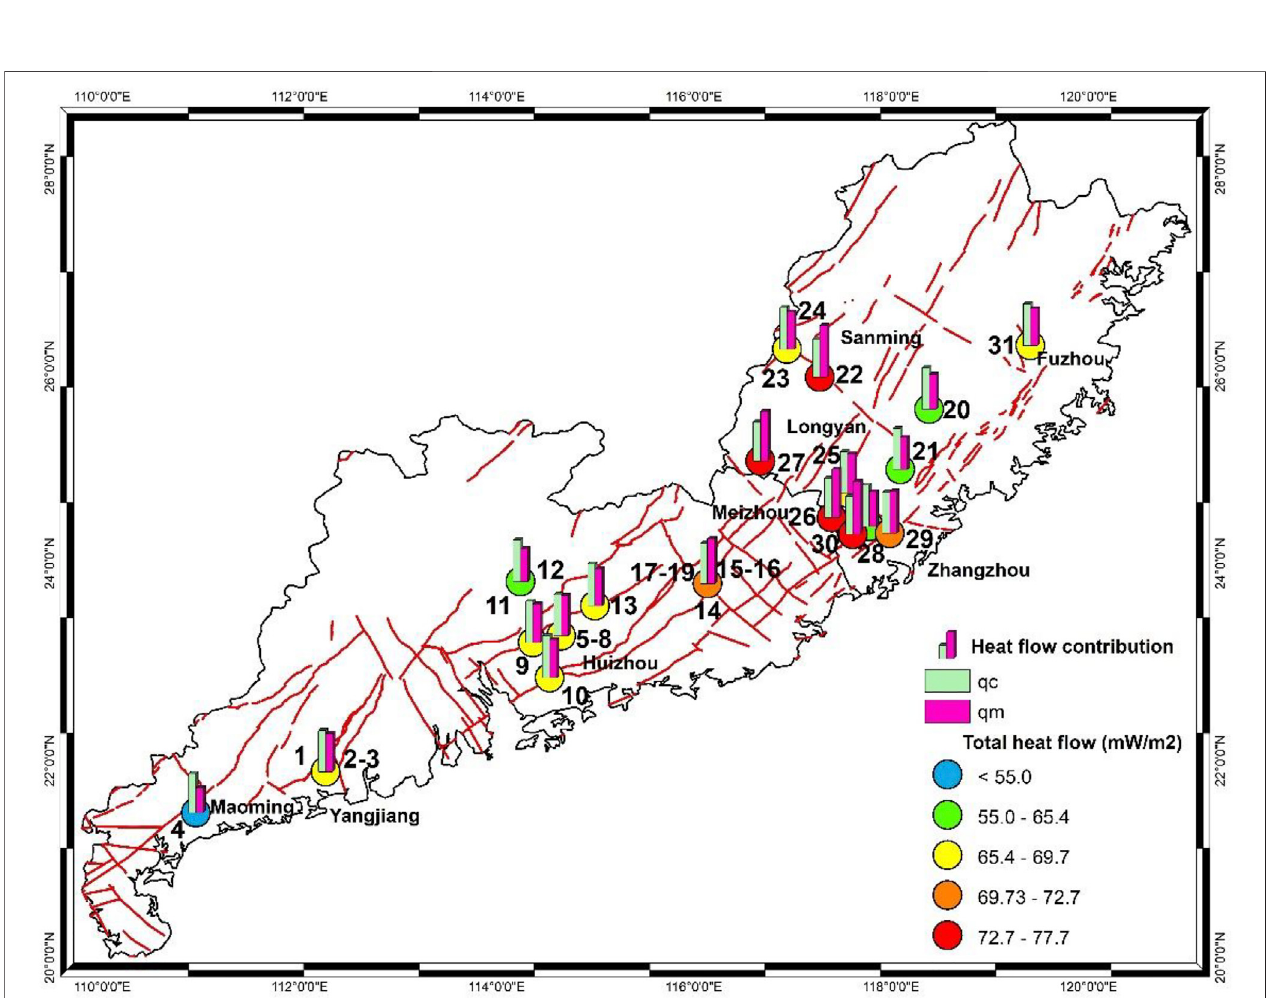
Frontiers in Earth Science |